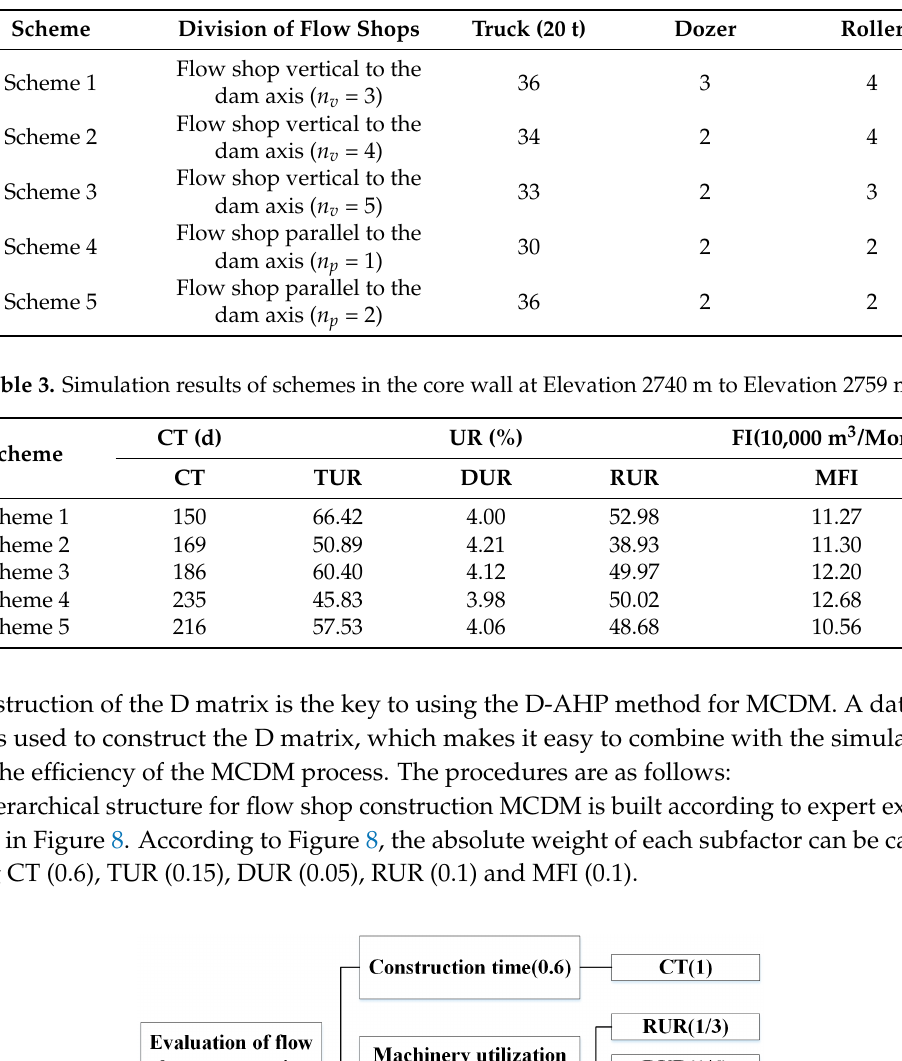
Figure 8. A hierarchical structure for flow shop construction multi-criteria decision making (MCDM).